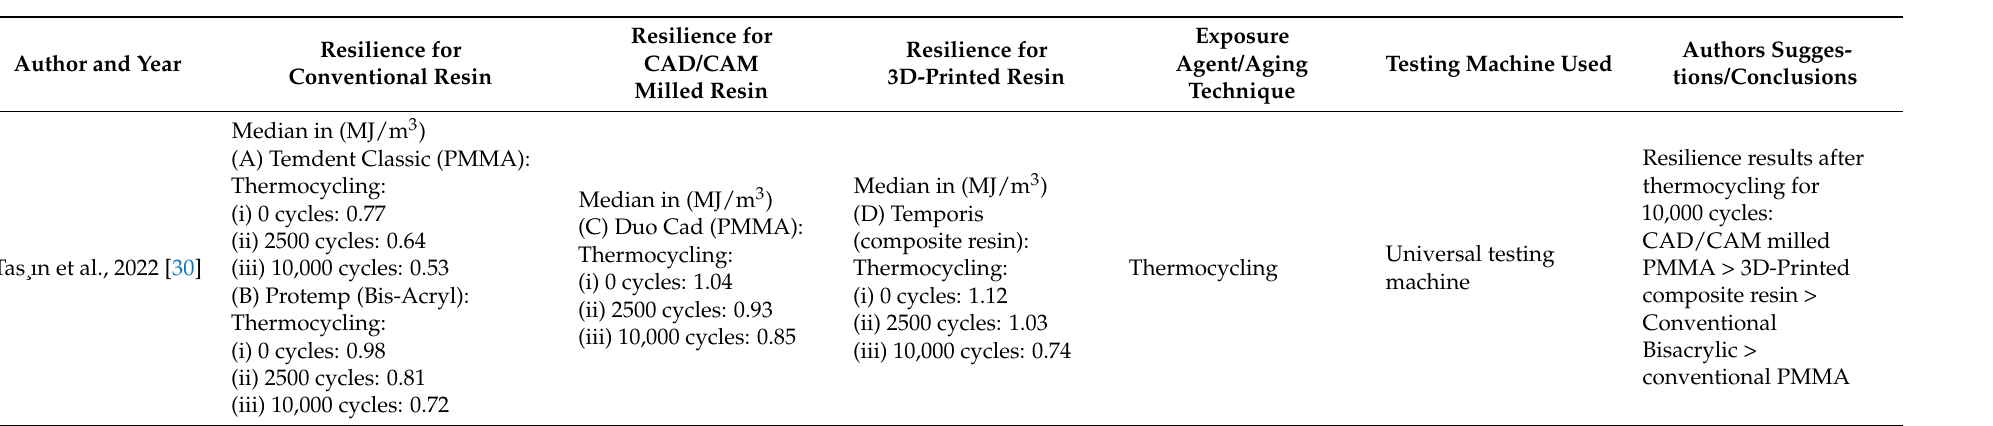
Table 15. Resilience Results (MJ/m 3